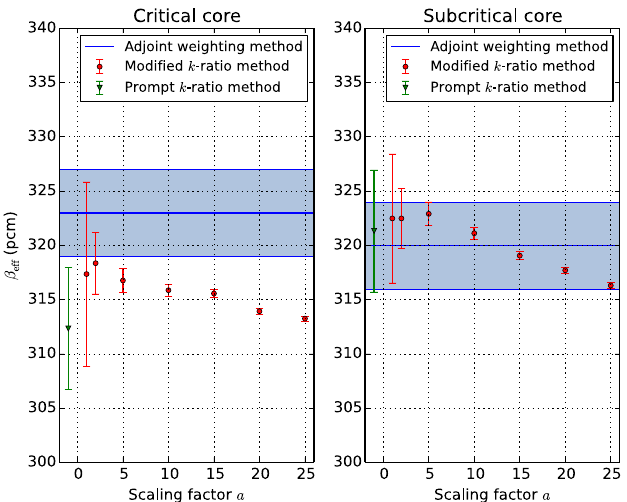
Fig. 3. Comparison of the b eff values for different scaling factors calculated using Chiba ’ s modi fi ed k -ratio method and that derived using the adjoint weighting method. The error bars and the band with pale blue color indicate 1 s statistical uncertainty.